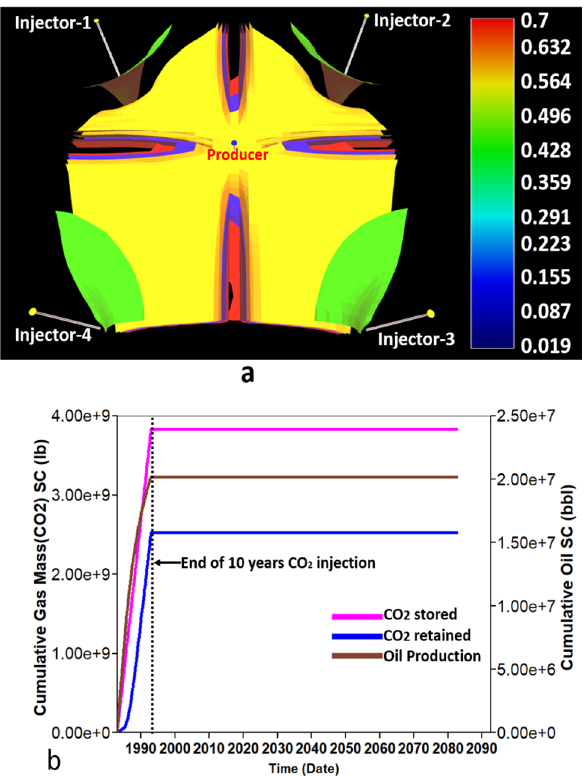
Figure 2. Base case reservoir simulation performance. ( a ) The iso-surface of oil saturation in the end of CO 2 injection scheme. ( b ) The cumulative CO 2 stored, CO 2 retained, and oil production in the 10 years injection followed by 90 years post-injection